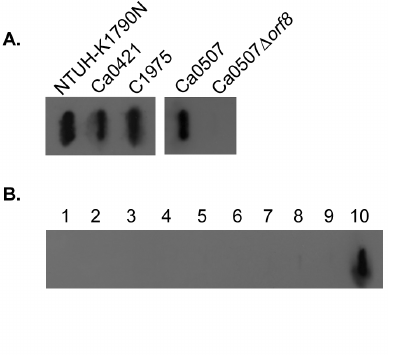
Figure 2. Immunoblot serotyping of K. pneumoniae NTUH- K1790N, Ca0507, Ca0421, and C1975. Rabbit anti-C1975 antiserum was used as the first antibody (1:5000) and goat anti-rabbit IgG-HRP as the second antibody (1:10 000). ( A ) The slot blot showing anti-C1975 antiserum reacts to the extracted capsular polysaccharides from strains NTUH-K1790N, C1975, Ca0421 and Ca0507. Ca0507 D orf8 presents the isogenic mutant with a deletion of gene orf8 in the cps . ( B ) The slot blot for the extracted capsular polysaccharides from 77 K serotype reference strains and a new type A1517. Sample1–9: K31 to K39; 10: C1975 as control. Negative reactions were observed in other reference strains and A1517 (data not shown).